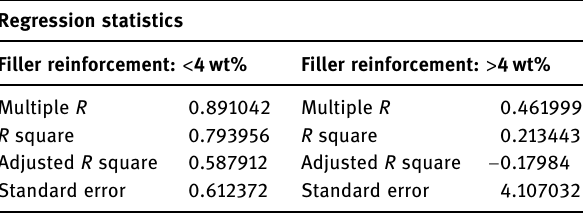
Table 2: Regression analysis of tensile strength and hardness Regression statistics